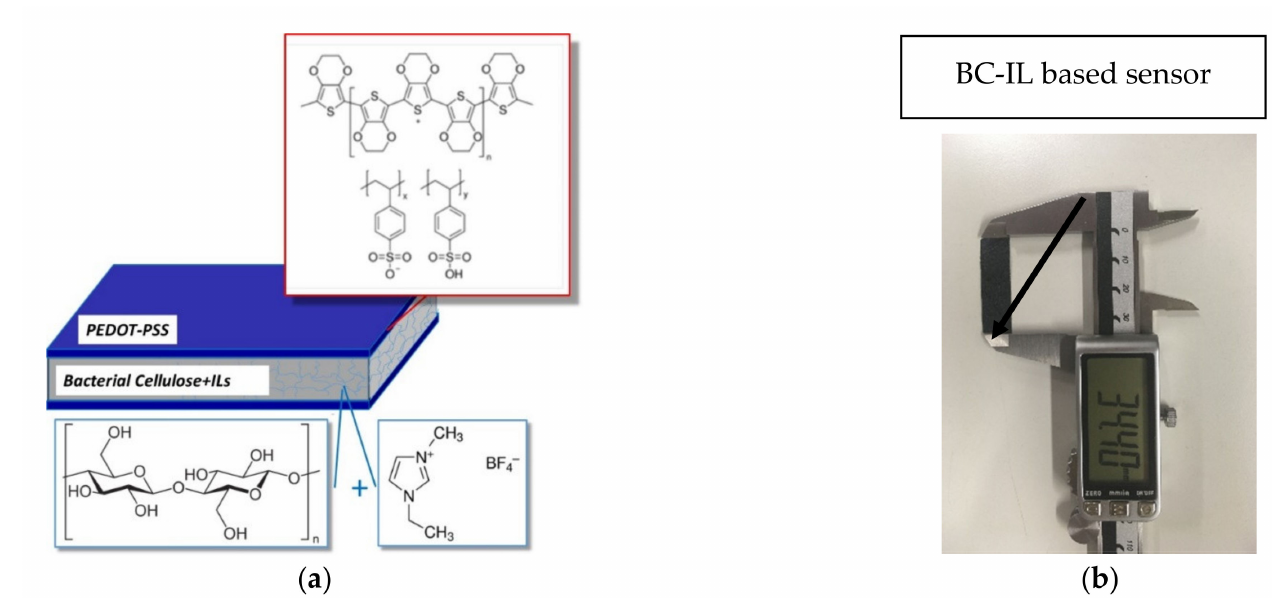
Figure 3. ( a ) Schematic of the obtained three-layer sensor; ( b ) a photo of the realized